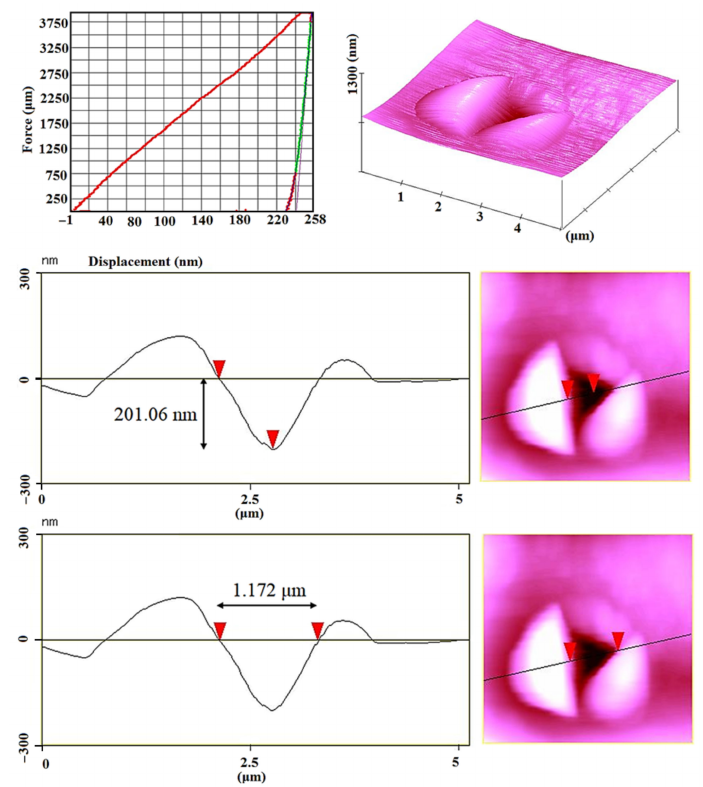
Figure 7. Loading–unloading curve, AFM image and its associated cross section for Fe 3 Al sample.